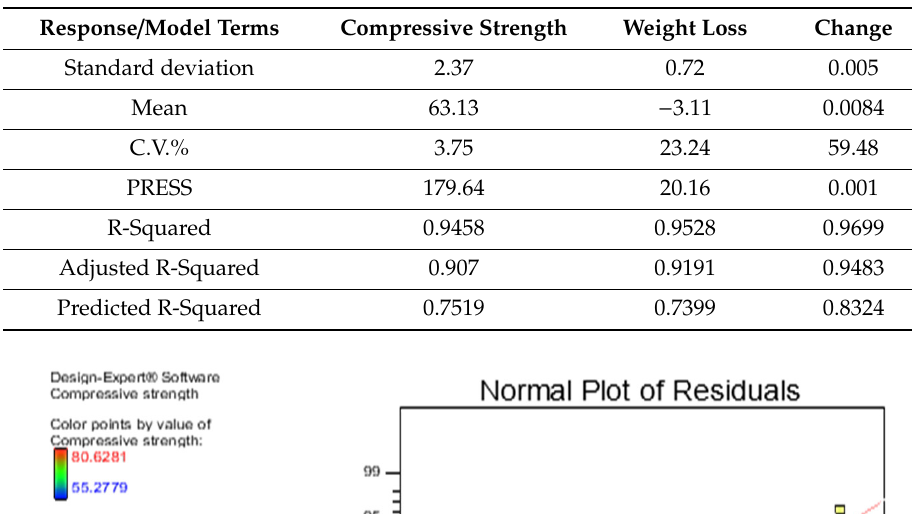
Table 5. Validation by model terms.